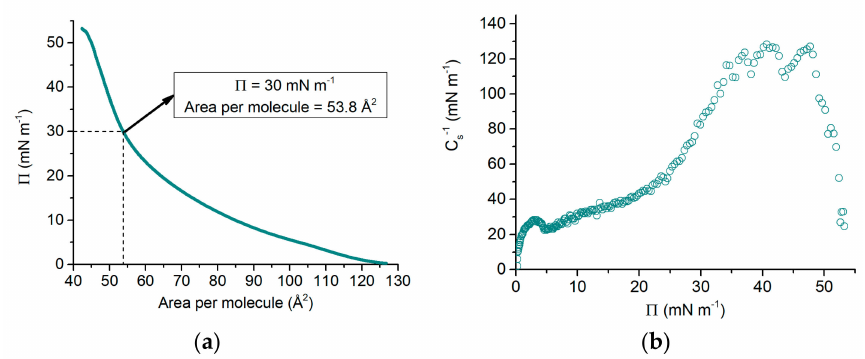
Figure 2. ( a ) Π - A isotherm of a DPPC monolayer at the air / bu ff er interface and ( b ) corresponding C s − 1 as a function of Π